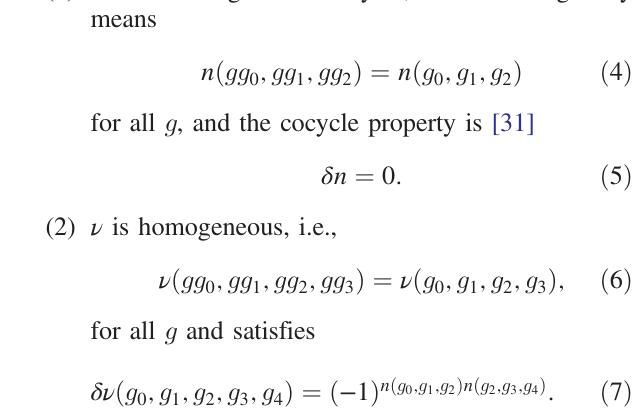
C j G j ⊗ ð ⊗ C 2 . p Þ pq Þ p h pq i ; f Z , i.e., product p g pq gi 1 is pq ¼ (cid:2)